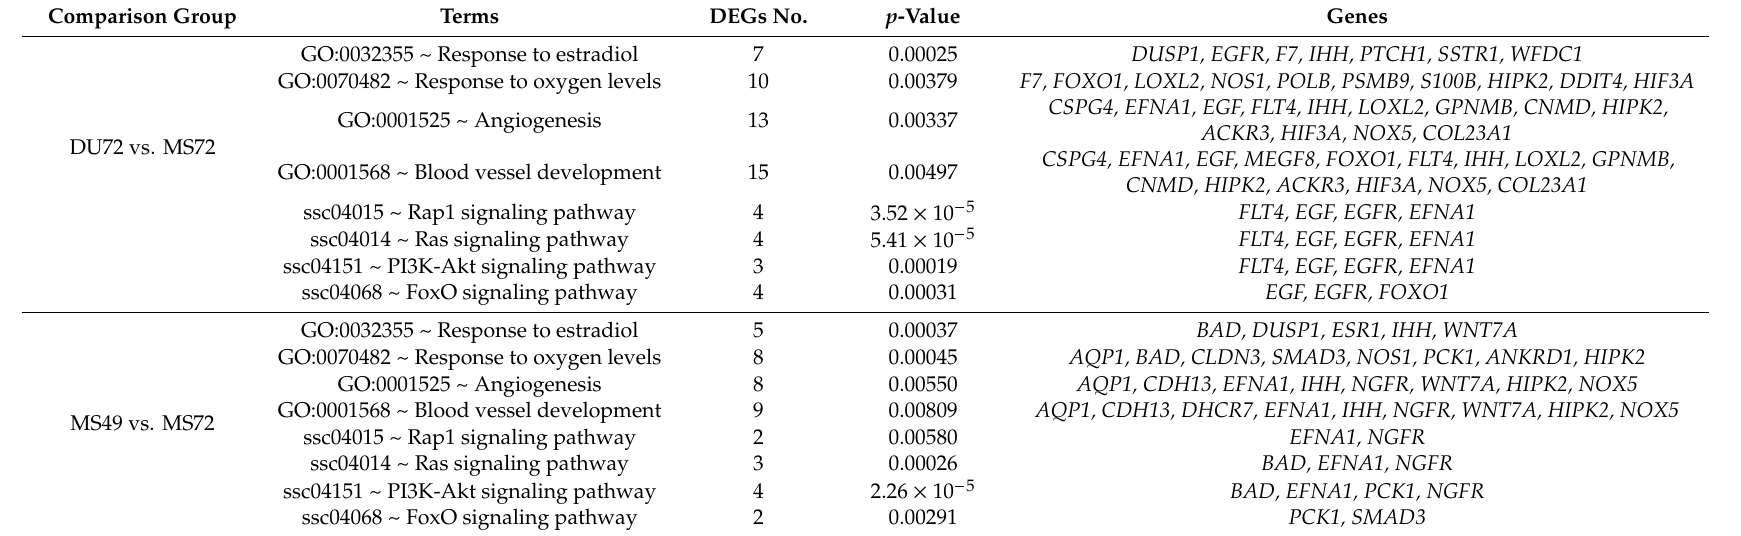
Table 3. Significantly enriched GO terms and associated KEGG pathways shared between DU72 vs. MS72 and MS49 vs. MS72 in miRNA-mRNA interaction networks. Comparison